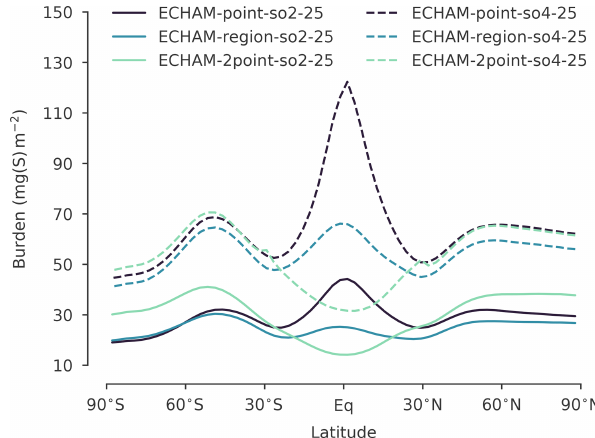
Figure 8. Zonal mean artificial sulfate burden for the ECHAM sim- ulations of the SO 2 injections (dashed lines) and the H 2 SO 4 in- jections (solid lines) with an injection rate of 25Tg ( S ) yr − 1 as a function of